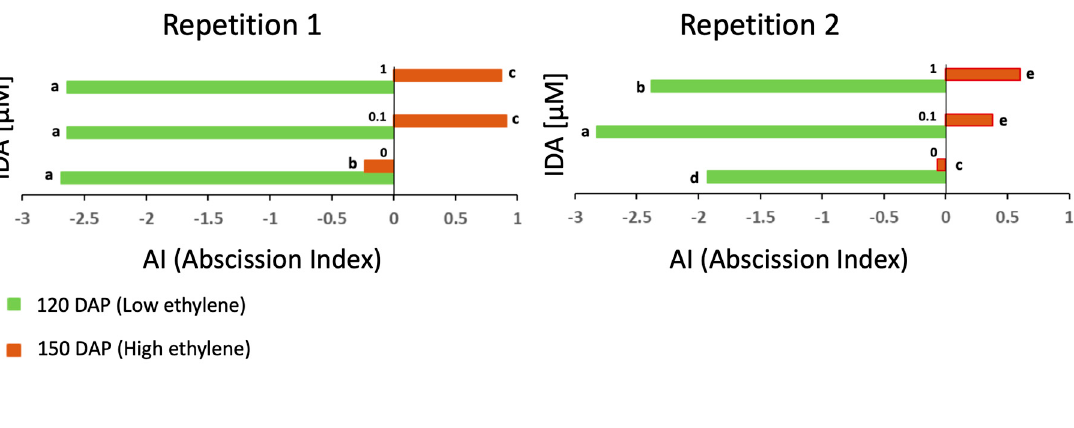
Figure 2. Cell separation in the oil palm fruit abscission zone (AZ) is enhanced significantly by treatments with the EgIDA peptide at concentrations of 0.1 or 1 µM, and the effect is only observed with ripe fruit. ( a ) There is a significant (p = 0.000036) effect of the EgIDA peptide on the abscission index (AI), and the effect is age-dependent (p = 0.00000). ( b ) A second repetition confirmed the significant (EgIDA × age of the fruit interaction, p = 0.000824) effect of the EgIDA peptide to enhance separation in AZs of ripe fruit (150 days after pollination (DAP)) when ethylene is produced, and not at an earlier stage of development (120 DAP) when ethylene production is low. Different lower-case letters represent statistically significant differences. Negative AI means less abscission, positive AI more abscission. The AI was calculated as described previously [24].